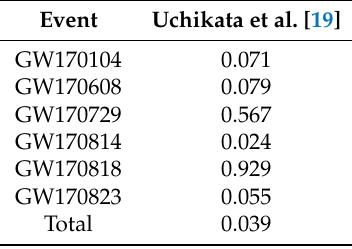
Table 8. p -values for O2 events